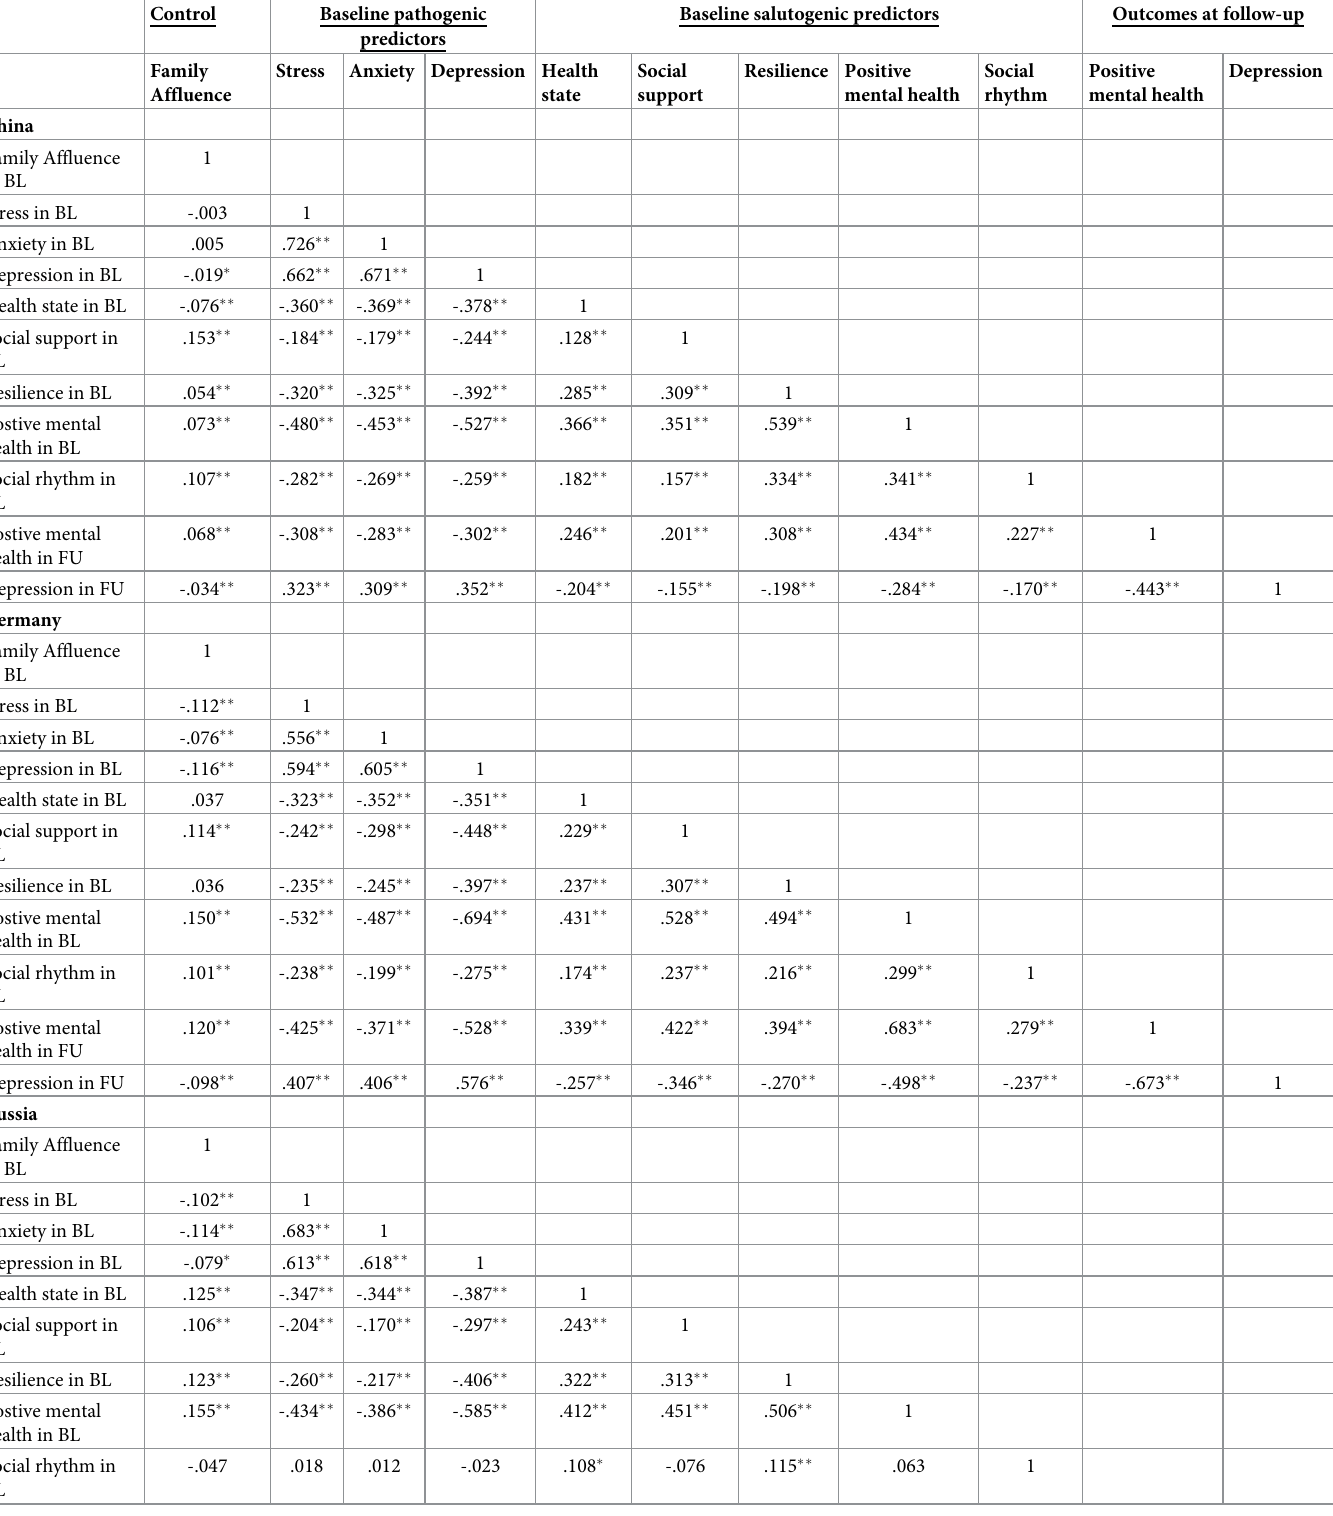
Table 2. The correlations among the psychological predictors within